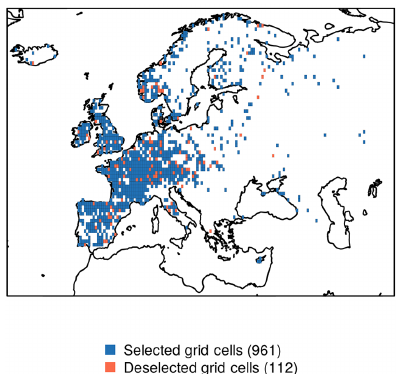
Figure 8. Final selection of grid cells with observations. Only grid cells with homogeneous time series were selected. See text for de-